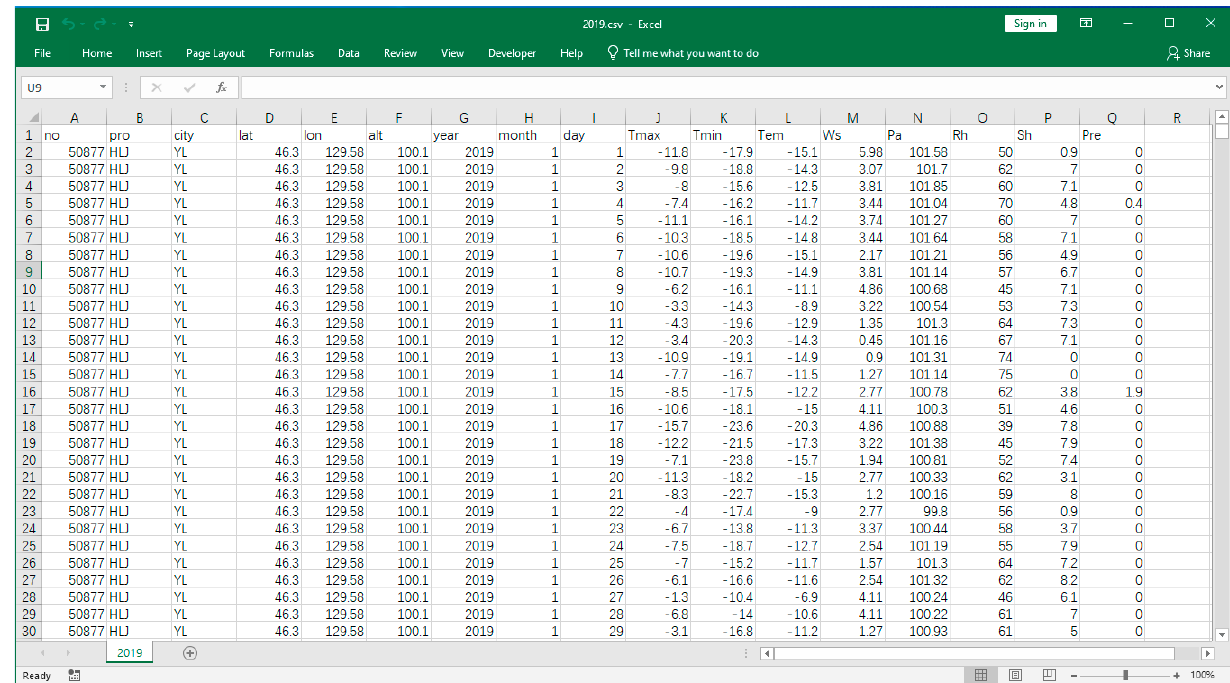
Figure 4. Schematic diagram of the structure of folder 1RemoteSensingData/ and folder 2Meteoro- logicalData/.